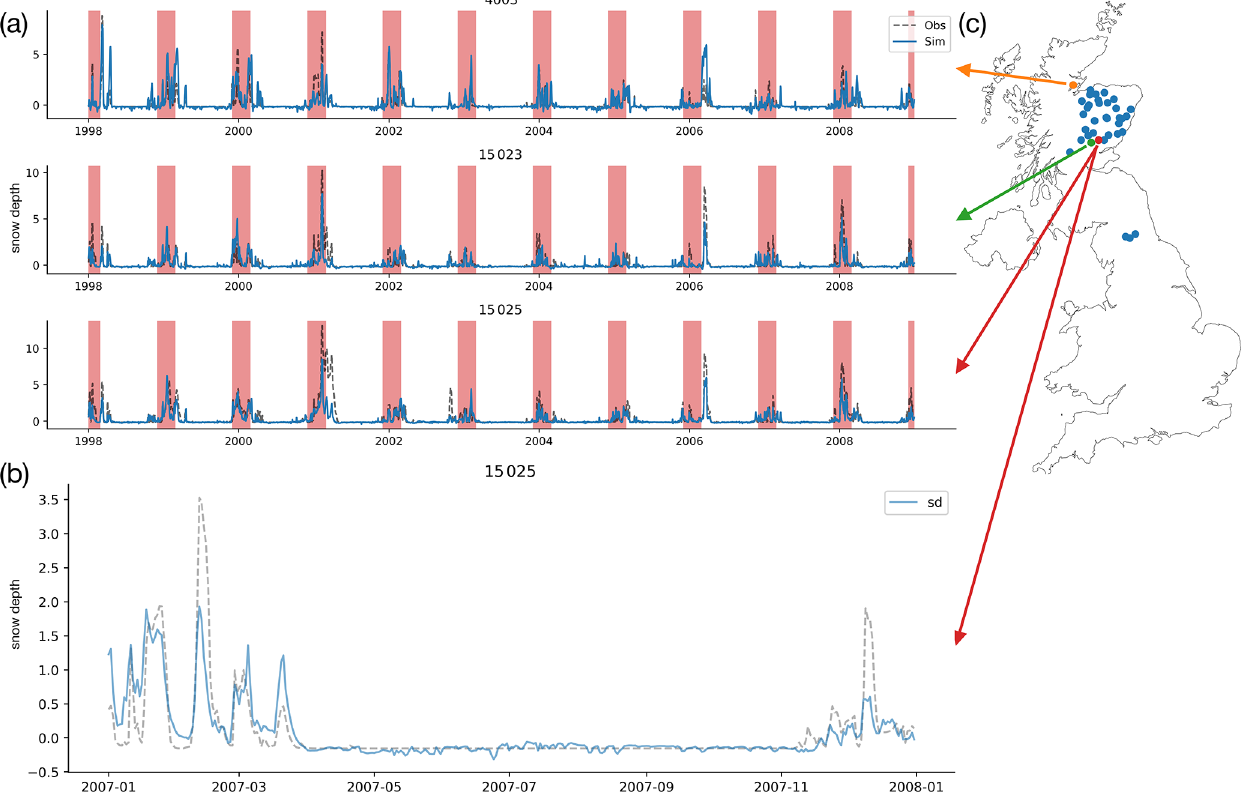
Figure 5. (a) The probe simulation (blue line) plotted against the snow depth variable from ERA5-Land (black dashed line) showing the correlation between the cell-state dimension and the target variable for all years in the training dataset (1998–2008). The red-shaded regions represent winter months (December, January, February). Each subplot shows results for a selection of the snowy catchments as selected from panel (c) . (b) Probe predictions for the snow depth target variable for a single snowy station, 15025 in the Cairngorms (the red point in c ), for a single year 2007. Panel (c) shows catchments with significant snow processes in Great Britain (defined as having a fraction of precipitation falling as snow greater than 5% using the CAMELS-GB frac_snow variable, which is the percentage of precipitation falling as snow) are concentrated in the Grampians range in north-eastern Scotland and the Pennines in northern England.